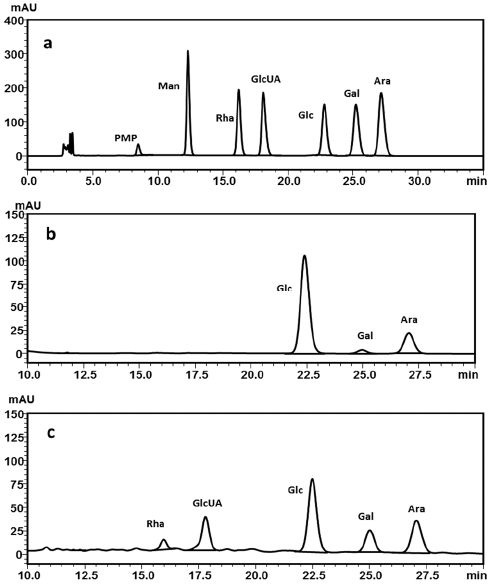
Figure 3. Chromatograms of monosaccharide compositions: ( a ) Six monosaccharides, ( b ) DRP1, ( c ) DRP2. PMP: 1-phenyl-3-methyl-5-pyrazolone.